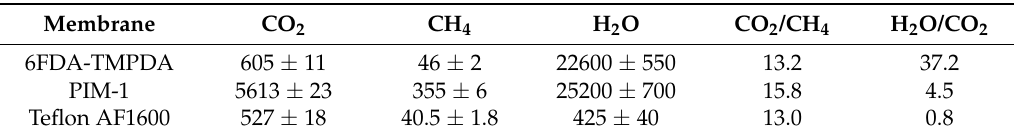
Table 3. Single gas permeability (barrer) in pure 6FDA-TMPDA, PIM-1 and Teflon AF1600 membranes, at 35 ◦ C.